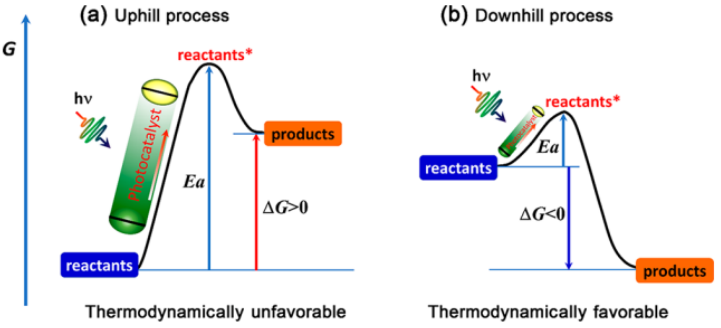
Figure 2. The schematic illustration of ( a ) uphill and ( b ) downhill reactions. Reprinted with permis- sion from Ref. [51]. Copyright 2018, American Chemical Society.